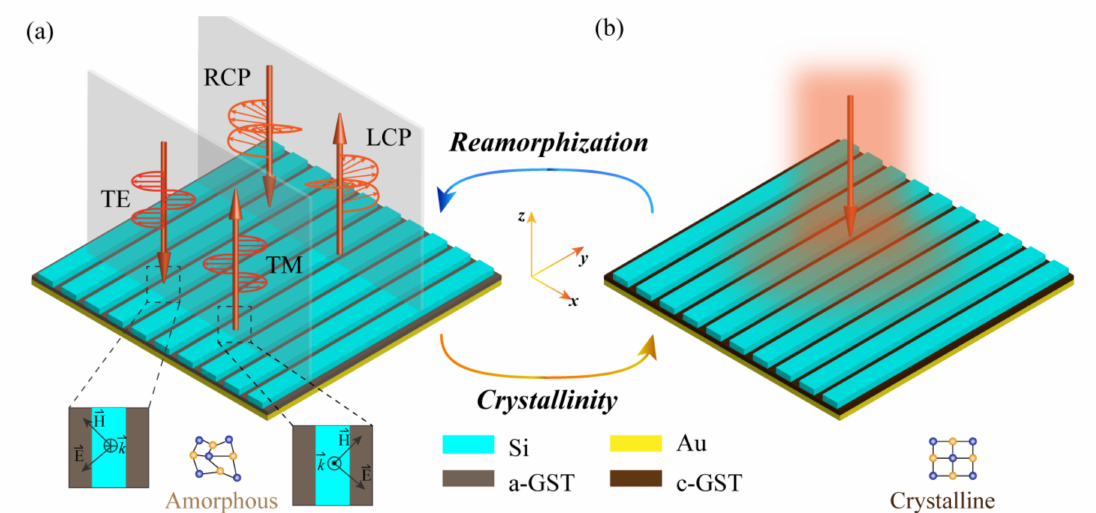
Figure 1. The schematic diagram of the proposed meta-grating. It can achieve broadband polarization conversion when the PCM is in amorphous state ( a ), and perfect EM absorption when the PCM changes to a crystalline state ( b ). The bottom insets in ( a ) depict the azimuthal angle between the electric vector of the EM wave and the main axis of the meta-grating. The crystallization levels of GST in ( a , b ) do not represent the real molecular